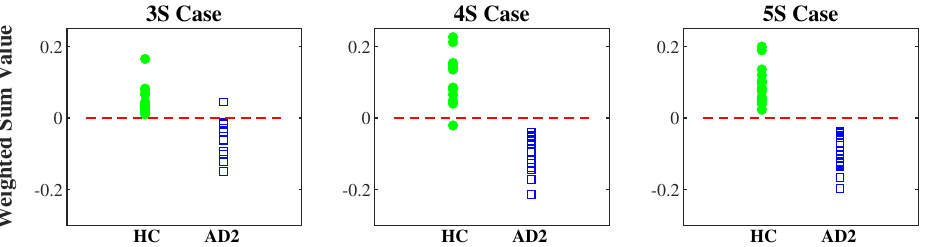
Figure 2. The weighted sum values of the 30 EEG signals recorded from the T4 electrode for the 3S–5S cases. The 15 circle and 15 square symbols are from 15 HC and 15 AD2 subjects,